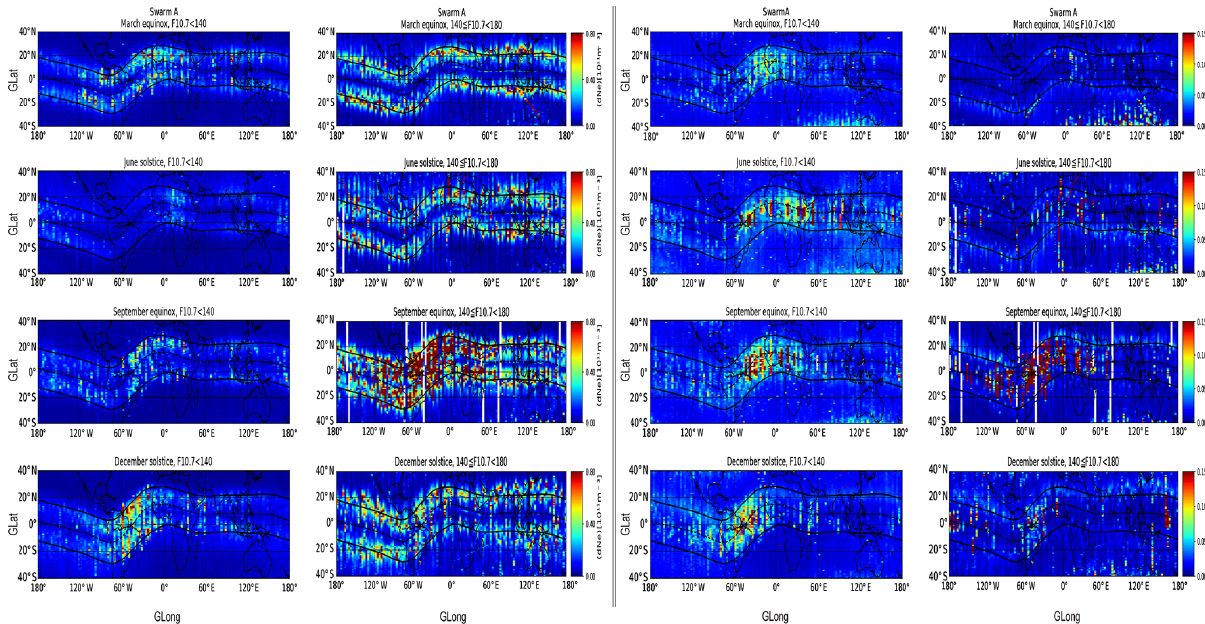
Figure 12. Solar activity effect on seasonal and longitudinal distribution of dN e and dN e /N e for the period from October 2014 to Octo- ber 2018: a case for Swarm A.